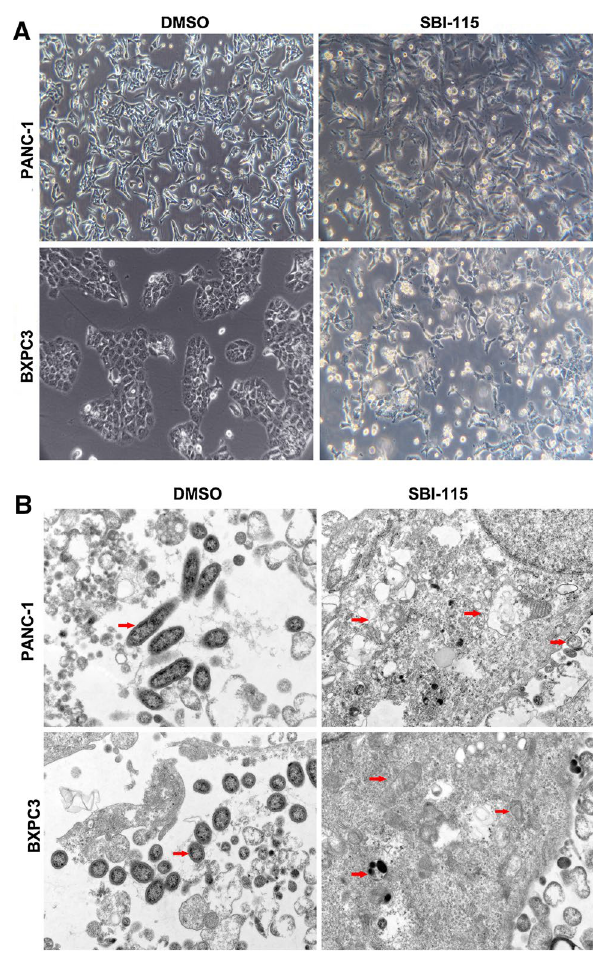
Fig. 4 The cell morphologies and ultrastructural changes induced by SBI-115 in vitro. A The cellular morphologies of PANC-1 and BXPC3 cells were observed by using the light inverted microscope (100 ×); B The ultrastructural changes in PANC-1 and BXPC3 cells were observed by trans- mission electron microscope (1 μm). The red arrows indi- cated the